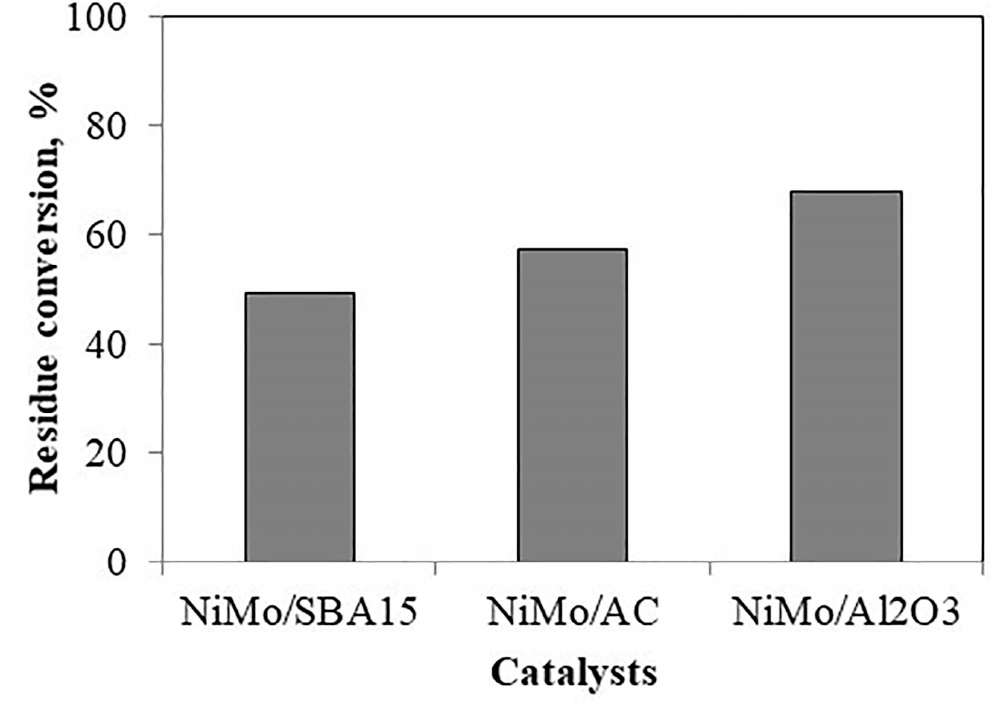
Figure 6. Residue conversion of NiMo-catalysts.